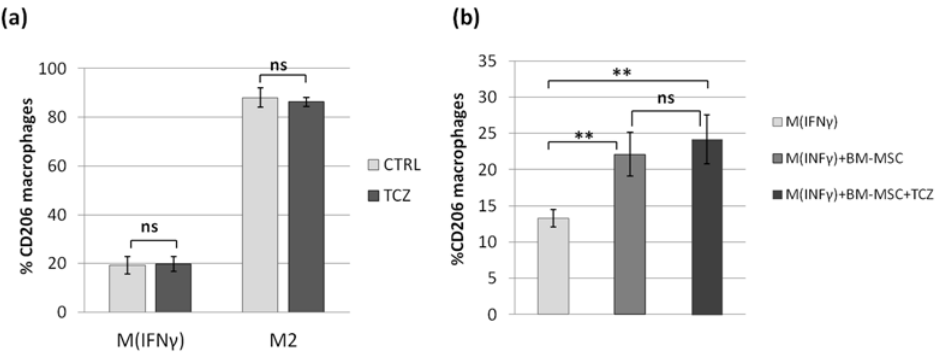
Figure 7. The effect of IL-6 receptor blockade with Tocilizumab on MSCs-related macrophage differentiation into the M2 phenotype. Immunocytochemical analysis. Bars represent the mean percentage of CD206 expressing cells within CD68+ cells (macrophages). ( a ) The effect of TCZ on CD206 expression in M IFN γ and M2 macrophages in monoculture ( n = 6); ( b ) The effect of TCZ on CD206 expression in M IFN γ cultured in co-culture with BM-MSCs for 3 days ( n = 12, macrophages from 3 donors and MSC from 4 donors were used in this experiment). Data analyzed using the Wilcoxon test or T-test for related data (depending on the data distribution, which was determined using the Shapiro–Wilk test) ** p < 0.01 For the comparison of the effect of MSCs with and without TCZ on CD206 expression, the difference (“ Δ ”) between CD206 expression after co-culture with MSCs (with or without TCZ) and the expression without the addition of MSCs, and then the “ Δ ” values for treated and untreated MSCs were compared as independent data (U Mann–Whitney test). ns—statistically not significant.